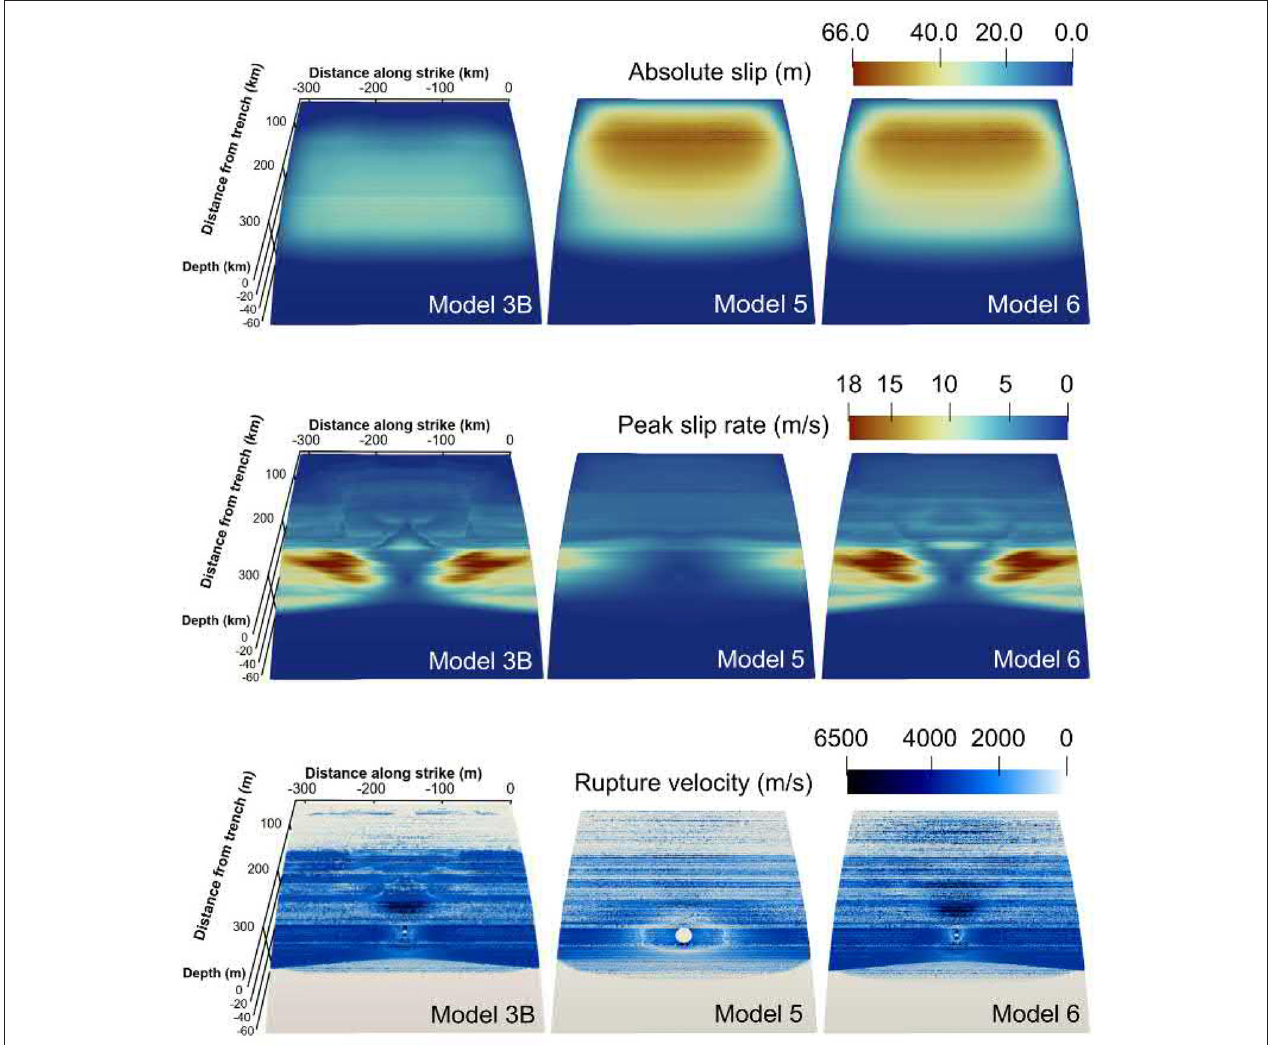
FIGURE 9 | Fault slip, peak slip rate, and rupture velocity for the dynamic rupture models 3, 5 (increased fracture energy), and 6 (higher Poisson’s ratio) after 200 s at the end of the DR simulation.